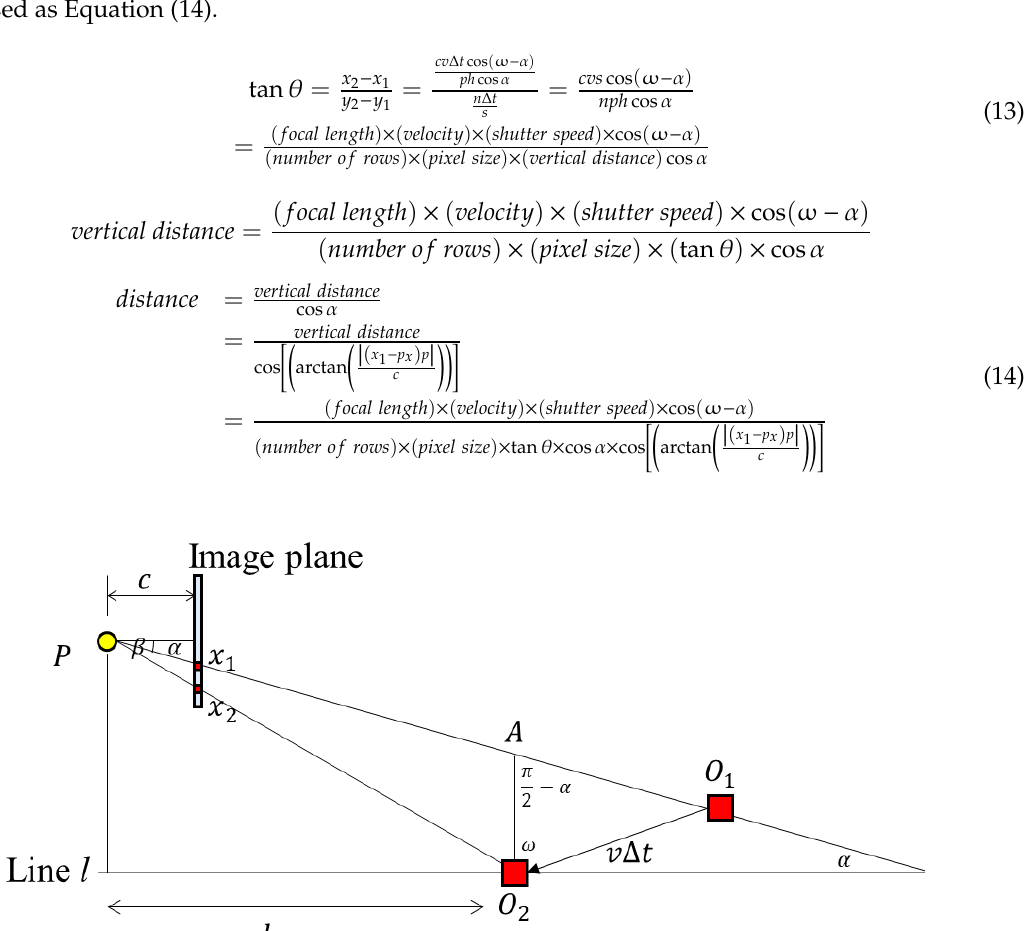
Figure 10. The RSE occurrence with the camera parameters and the moving scenario parameters (object moves diagonally).